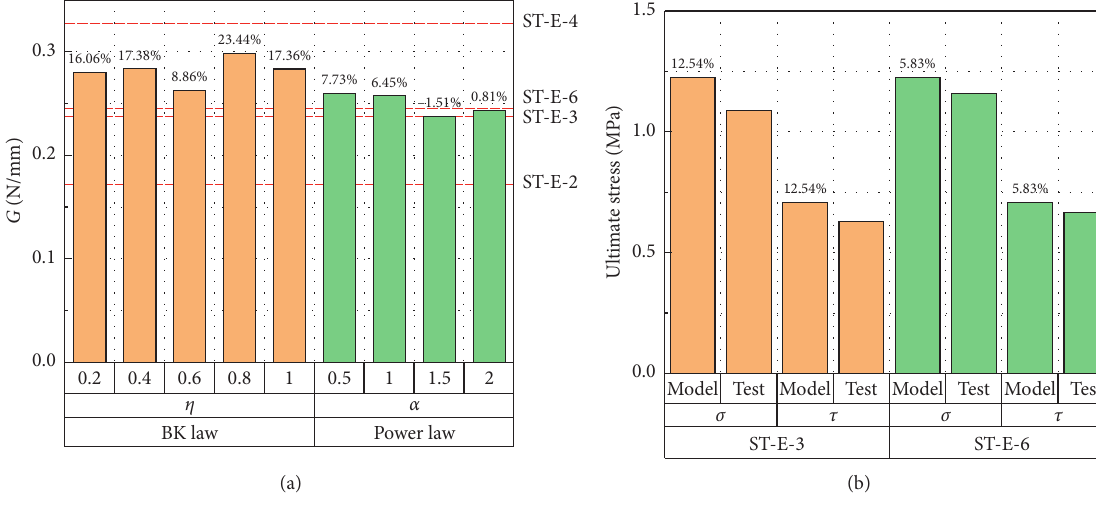
Figure 12: (a) Fracture energy comparison. (b) Interface ultimate stress